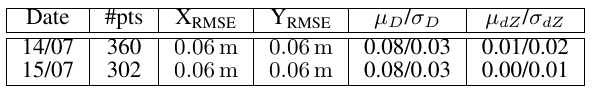
Table 3. Statistical values for the differences at the calibration track (precision and accuracy).